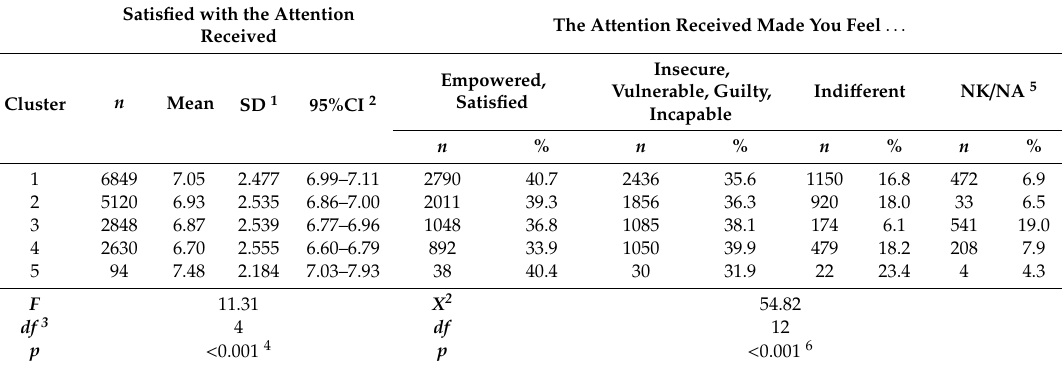
Table 6. Satisfaction with the attention received per cluster group ( n =